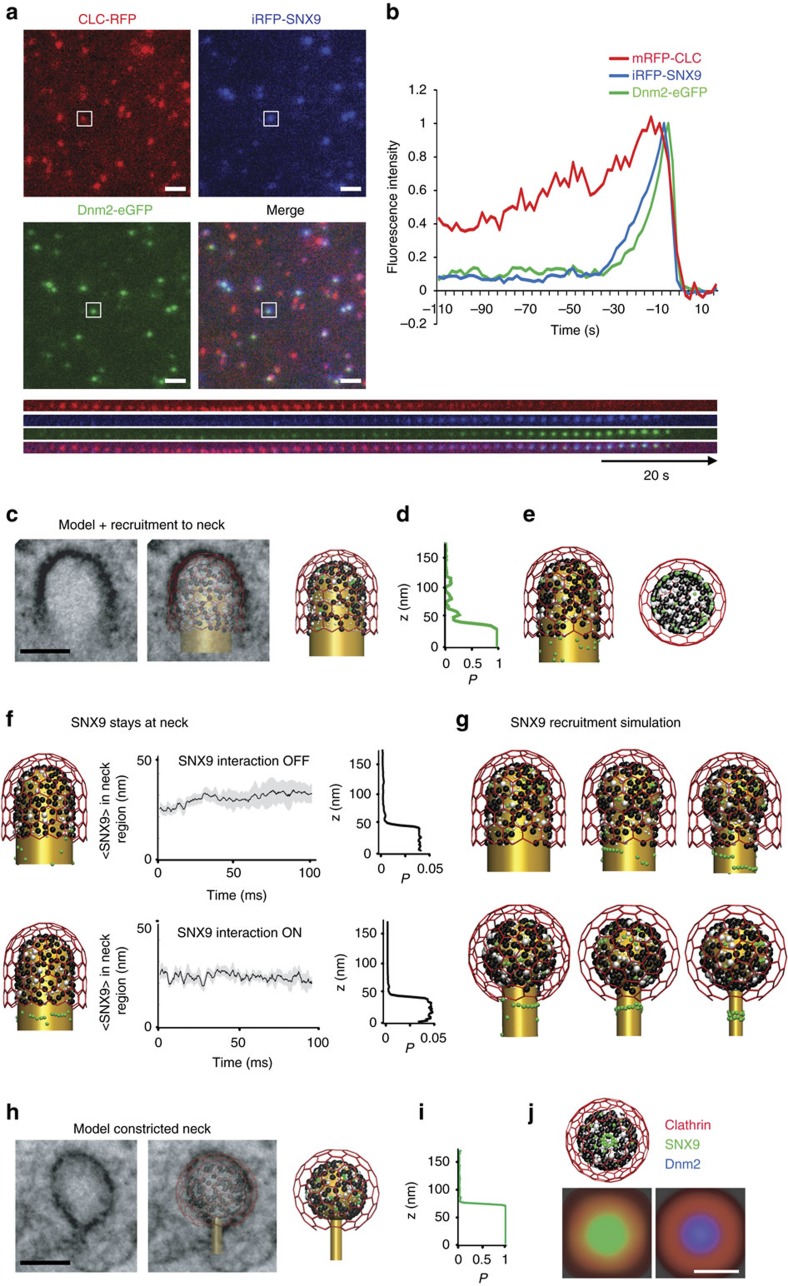
Spatiotemporal model of SNX9 recruitment and nanoscale localization.(a) Representative TIRF images illustrating the localization of iRFP-SNX9, endogenously tagged clathrin light chain (CLC)-mRFP and dynamin 2 (Dnm2)-eGFP in SK-MEL-2 cells depleted of endogenous SNX9/18. Scale bar, 2 μm. (b) Average recruitment of iRFP-SNX9 and endogenously tagged CLC-mRFP and Dnm2-eGFP in SK-MEL-2 cells (n=60 CCPs from four cells). (c–e) High protein densities under the clathrin coat are predicted to lead to SNX9 recruitment predominantly towards the neck. (c) Comparison of computational model and corresponding EM image in a pre-constricted state. The membrane (gold) forms a U-shaped structure coated by AP-2 (black), other endocytic proteins (grey) and clathrin (red). Few SNX9 molecules (green) are present in the coat due to PI(4,5)P2-binding. Scale bar, 100 nm. (d) Probability to recruit SNX9 to a given position on the z axis. Space exclusion in the protein-dense dome region leads to most SNX9s being recruited to the neck. (e) Configuration after 20 SNX9 molecules have been recruited (side and bottom view). (f) Brownian dynamics simulations show that SNX9 remains predominantly in the neck region (three independent simulations, grey depicts s.d.). This is the case when both (top) SNX9 molecules do not interact, and when (bottom) SNX9 forms oligomers by a tip-to-tip interaction potential promoting ring formation (see Supplementary Information and Supplementary Fig. 2). Left: snapshot of the simulation, middle: time evolution of the SNX9 fraction at the neck, right: SNX9 z-coordinate residence probability. (g) Snapshots of neck constriction and Snx9 recruitment simulations. SNX9 tip-to-tip interactions induce oligomer formation. (h) Constricted neck simulation model is based on EM imaging (compare Fig. 2, colour as in c). The higher curvature increases the protein density under the coat. Scale bar, 100 nm. (i) Probability to find SNX9 molecules at a given z position. SNX9 is almost completely located at the neck, as the increased coat protein density allows for few vacancies. (j) Structure shown from the bottom after SNX9 rings have formed and as a simulated STORM image from the bottom view using a Gaussian blurring filter that mimics a 25 nm resolution (compare to g,h).